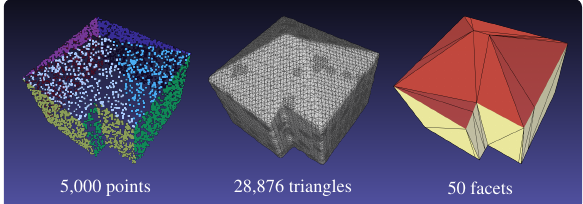
Figure 1. 3D modelling of a building from remote sensing data. Left : raw data (a 3D point cloud), without topological information. Middle : a mesh, many details but no semantics. Right : a model, high compaction and explicit semantics for each architectural feature ( roof - fa¸cade